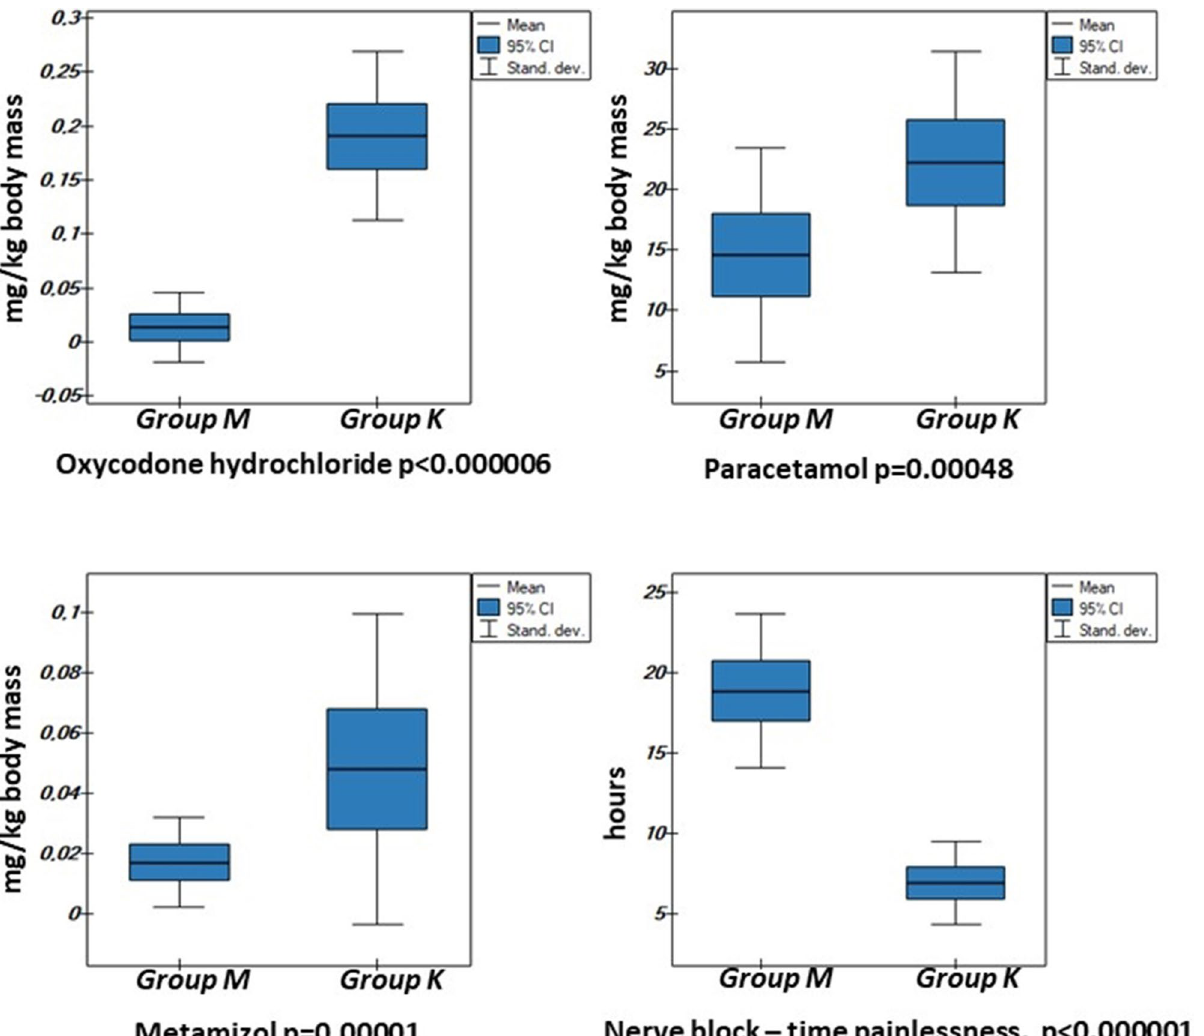
Figure 5. Dose of oxycodone hydrochloride in mg/kg body weight, paracetamol in mg/kg body weight, metamizole in g/kg body weight and time of postoperative analgesia in hours (h) not requiring